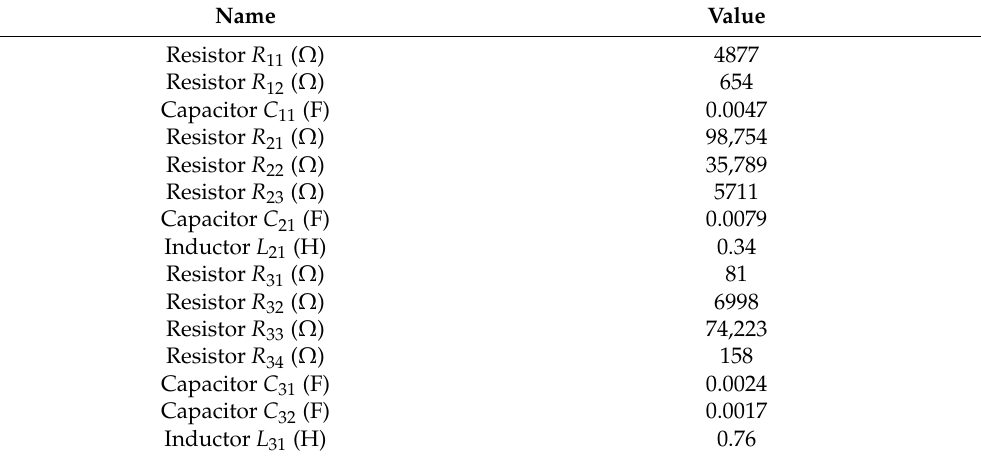
Figure 5. Electrical network. ( a ) Bivariate transfer function electrical network; ( b ) Biquadratic transfer function electrical network; ( c ) Bicubic transfer function electrical network. Table 2. Electrical network parameters.